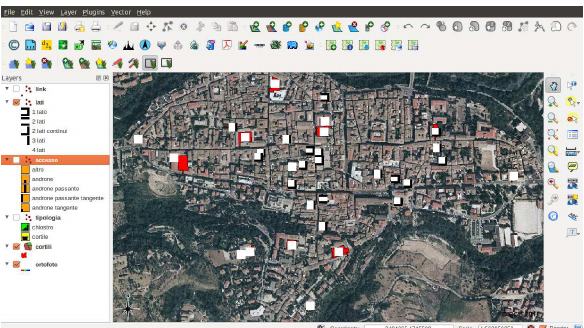
Figure 6. Icons to identify numbers and type of sides